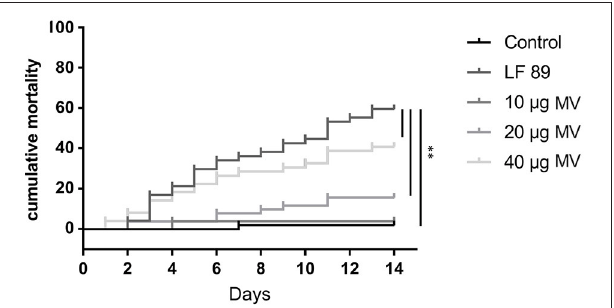
FIGURE 3 | Cumulative mortality (%) of adult zebrafish challenged with membrane vesicles (MVs) isolated from Piscirickettsia salmonis LF-89 type strain. Adult zebrafish were injected with 10, 20, and 40 µ g of MVs isolated from P . salmonis . PBS and live P. salmonis LF-89 were used as controls ( n = 20). Asterisks indicate statistical significance ( P <